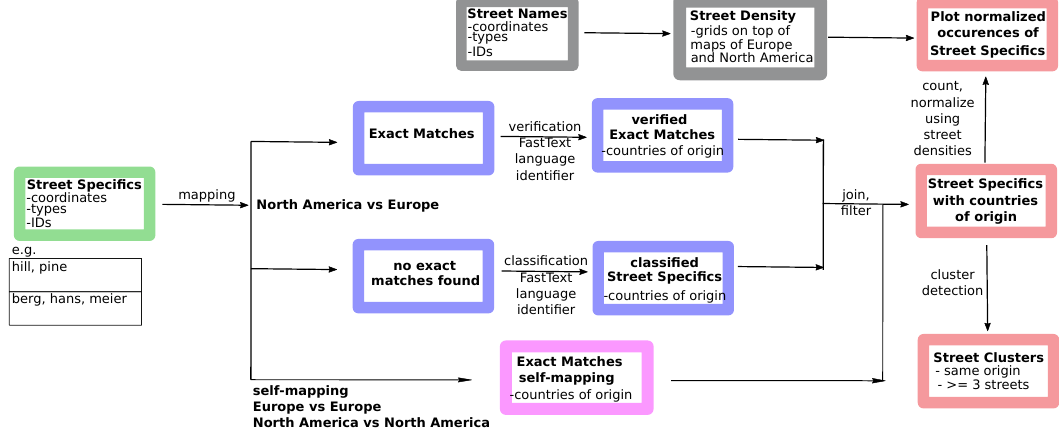
Figure 2. Workflow describing the analysis of specific street terms in Europe and North America (green). In order to classify American street specifics, exact matches to European street terms are used. Resulting exact matches are verified with a language identifier whereas the language identifier is used to classify countries of origin for street terms where no exact matches could be found (blue). In case of self-mappings of Euopean street terms to European street names and analogously for North America, only exact matches are used (pink). Plotting occurences of streets of common origin (upper red) is done by normalizing counts using street density data (grey). Resulting street specifics are also used for the detection of street clusters (lower red). See description in the text for more